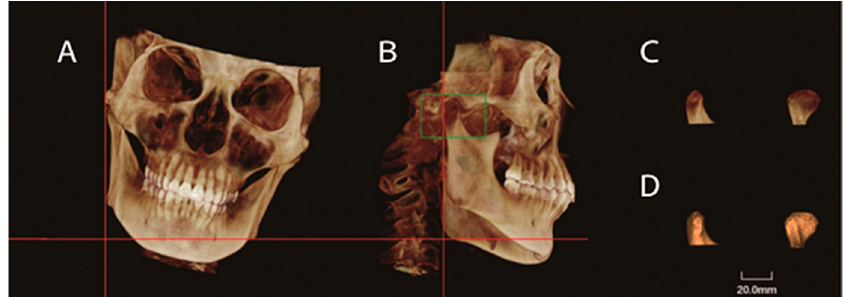
Figure 5. Condylar volume measurements. ( A , B ) Reorientation of the CBCT image before the meas- urements of condylar volume. The 3D image was rotated to align the mandibular ramus vertically. The inferior limit of the condyle was determined by the horizontal plane passing the deepest point of the sigmoid notch. ( C , D ): Condyles were delimited and cropped. The volume of each condyle was displayed in cubic millimeters (mm 3 ).